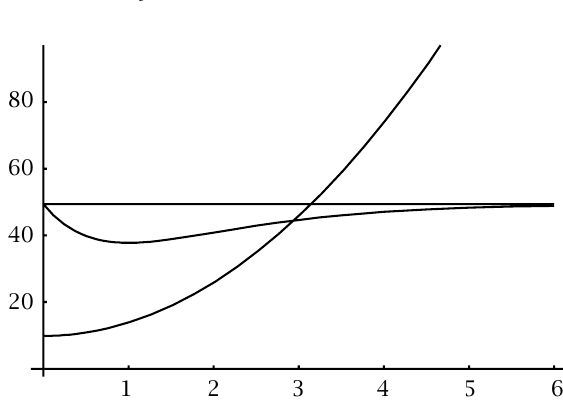
Figure 6.10 . F 1 (x) , F 2 (x) , and y = bπ 2 for b =